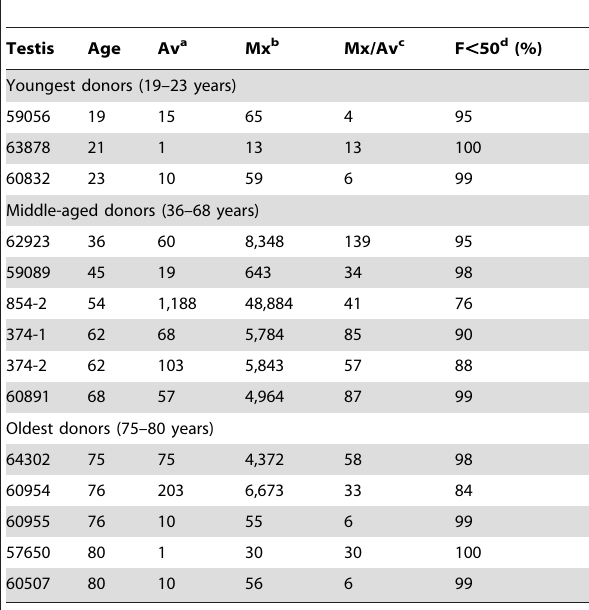
Table 1. MEN2B mutation frequency summaries from 14